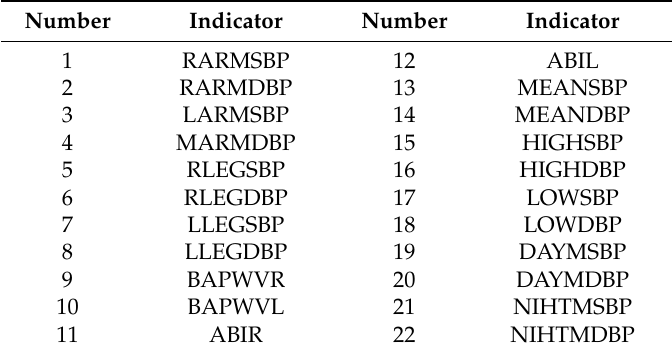
Table 1. Hypertension related